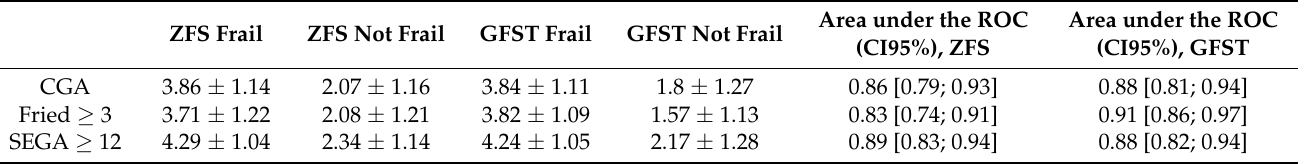
Table 10. Concordance with the comprehensive geriatric assessment (CGA).